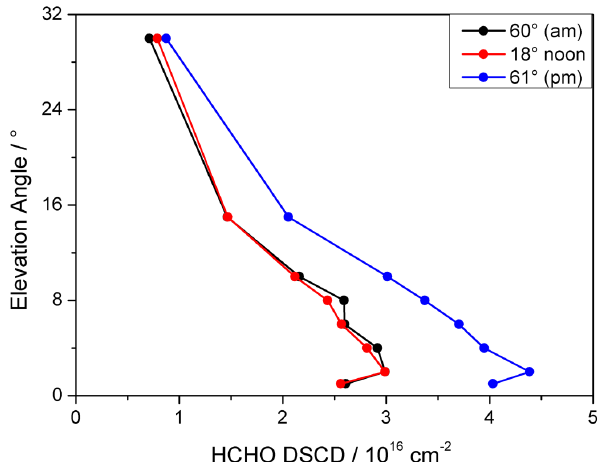
Fig. 7. HCHO differential slant column density vs. viewing angle on 24 June 2008 for 3 different solar zenith angles: 60 ◦ (around 08:00LT – black), 18 ◦ (noon – red) and 61 ◦ (around 16:00LT – blue). Note the large increase in HCHO between the two profiles with solar zenith angles = 60 ◦ . The noon profile exhibits a compar- atively small slant column density because the solar zenith angle is only 18 ◦